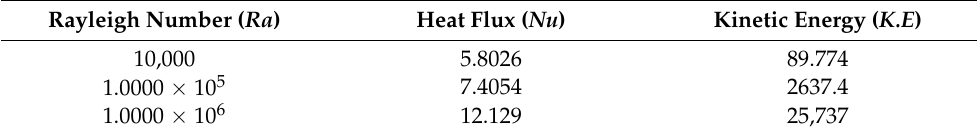
Table 2. Variation in kinetic energy for different values of the power-law index ( n )